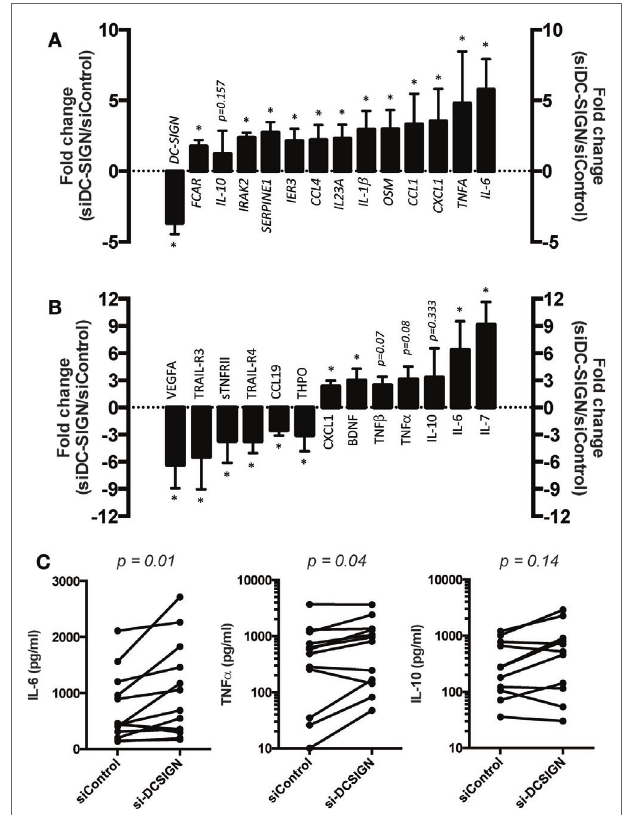
FigUre 3 | DC-SIGN regulates the pro-inflammatory response by M(IL-4) macrophages against Mtb. Human monocytes were differentiated into macrophages using M-CSF. At day 5, macrophages were transfected with siRNA targeting DC-SIGN (siDC-SIGN) or a non-targeting siRNA (siControl). The following day, the cells were activated with IL-4 (20 ng/ml) for 48 h to induce M(IL-4) program. The cells were then infected with Mtb at multiplicity of infection (MOI) of 3 bacteria to 1 cell. At 18 h p.i ., the cells were harvested and their supernatant collected. Assessment of (a) gene mRNA expression by qRT-PCR analysis, and (B) cytokine and chemokine content by semi-quantitative antibody array. Vertical bar graphs illustrate the fold change of mRNA/protein levels in siDC-SIGN over siControl macrophages; “0” was set arbitrarily to represent no change. Results are expressed as mean ± SD ( n = 4 donors). One-tailed Mann–Whitney (unpaired/nonparametric): *P < 0.05. (c) Assessment of cytokines by ELISA analysis. Results are expressed as before-and-after plot for the indicated genes ( n = 11 donors). Each circle within the plots represents a single donor. Two-tailed Wilcoxon (matched-paired/nonparametric): P < 0.05 was considered as the level of statistical